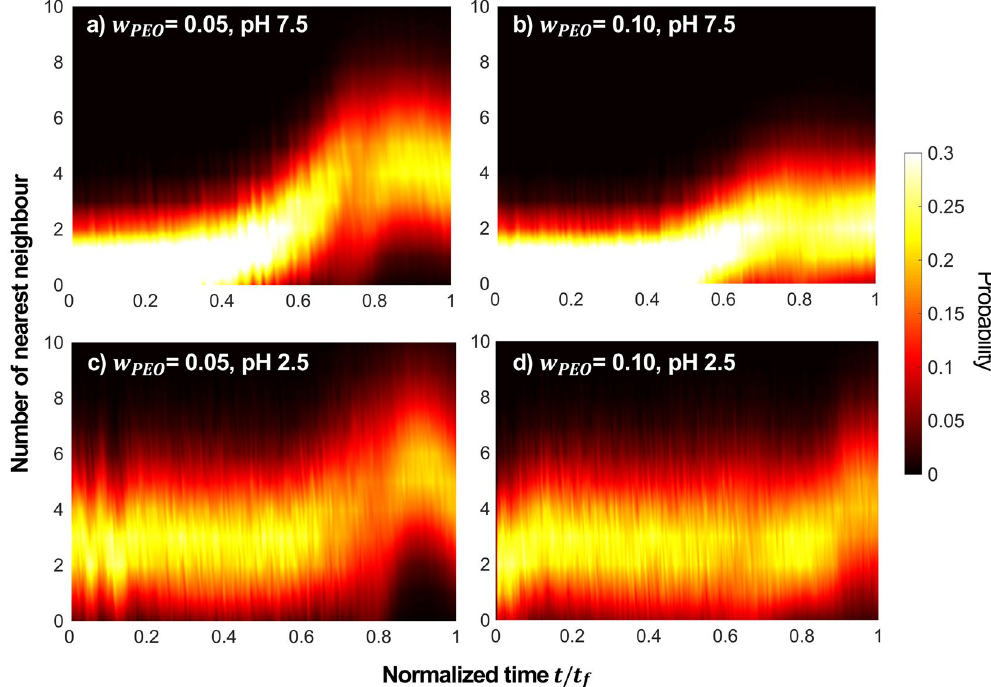
Figure 5. Distribution of neighbours in contact, N contact , of SiO 2 during drying. The samples were prepared at = 0.05 and ( a ) w = 0.05 at pH 7.5, ( b ) w φ 0 PEO at pH 2.5. Probability of number of N contact is indicated in a colour